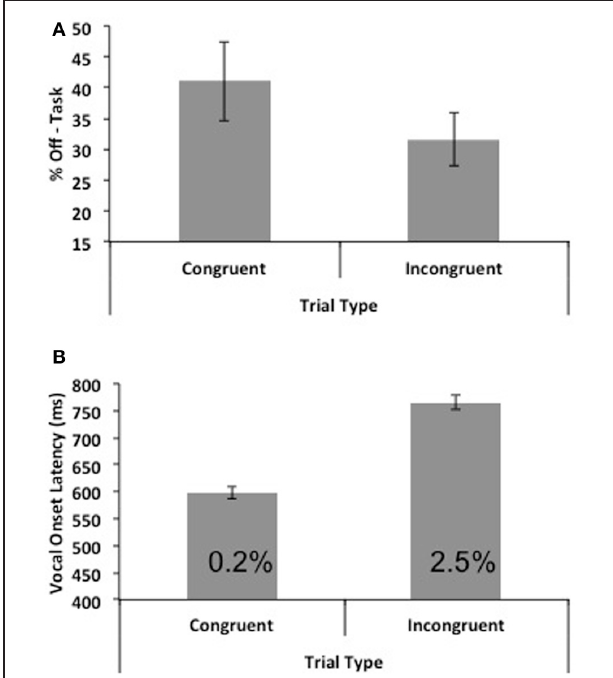
FIGURE 2 | (A) Mean percentages of “off-task” responses to the thought probes as a function of trial type. (B) Mean vocal onset latencies as a function of trial type and sample (and corresponding error percentages). Error bars represent one standard error of the